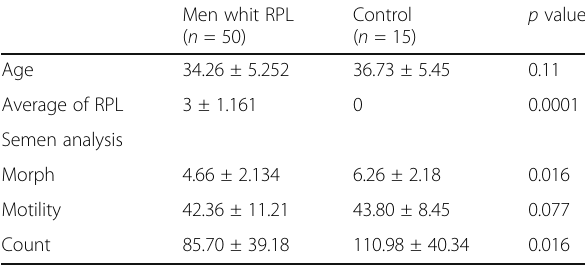
Table 1 Baseline characteristics of men with recurrent pregnancy loss (RPL) and normal men Men whit RPL ( n =